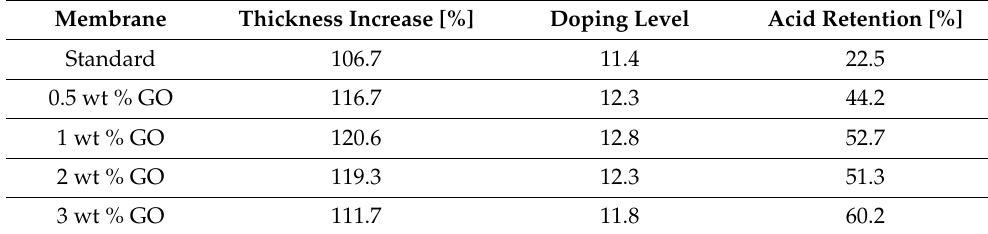
Table 1. Values of the thickness increase, ADL, and phosphoric acid retention of the studied PBI membranes.